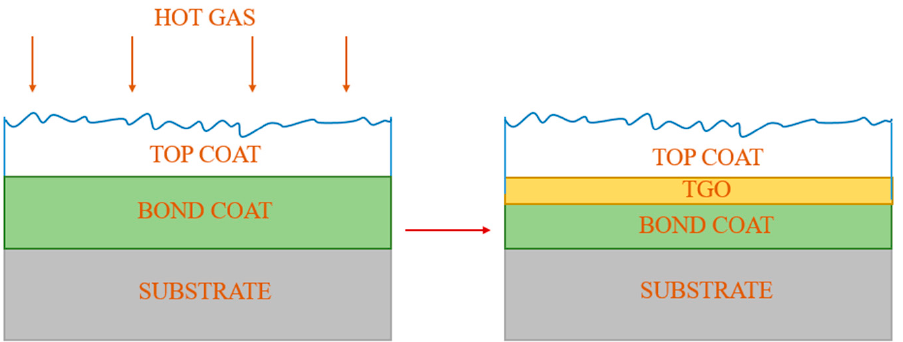
Figure 2. Schematic of TBC system formation.